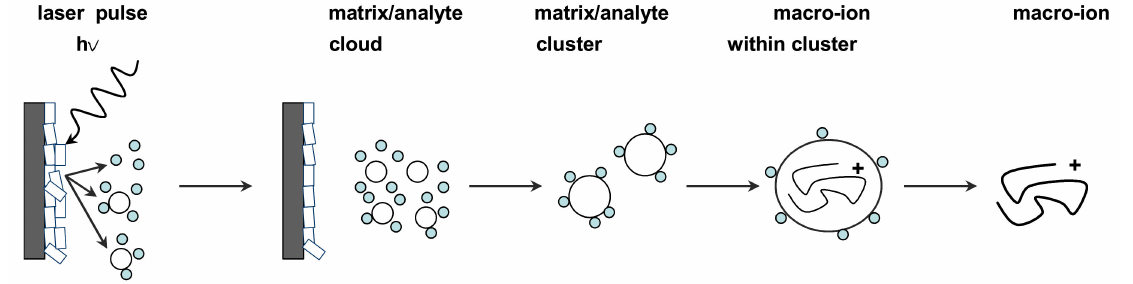
Figure 1. General representation of the desorption/ionization principle in MALDI-MS. Using a UV laser pulse, a matrix/analyte-particle cloud is desorbed from the co-crystalline matrix/sample solid solution deposited on a metal target. Proton-transfer from matrix ions is thought to be primarily responsible for the subsequent generation of analyte ions that are transferred to the mass analyzer and detected.